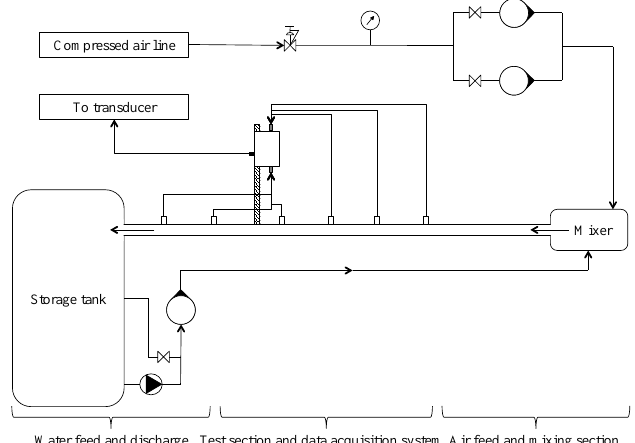
Figure 2. Layout of the experimental loop.